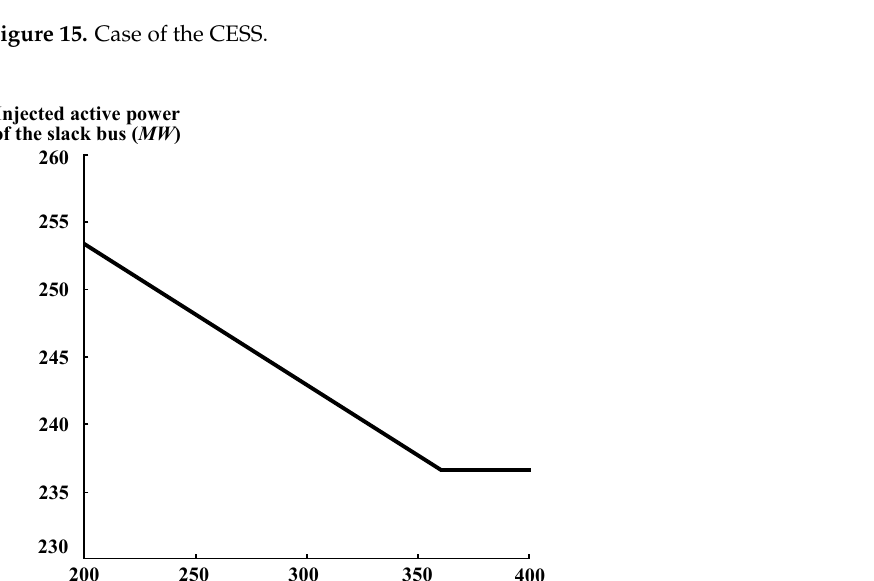
Figure 15. Case of the CESS.